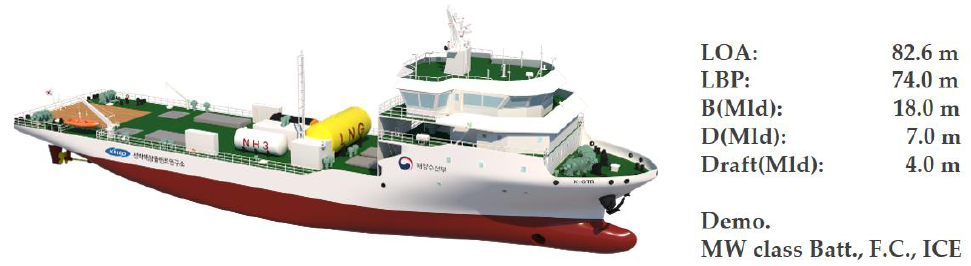
Figure 15. BSS to be equipped; 2600 GT class K-GTB appearance and specifications.